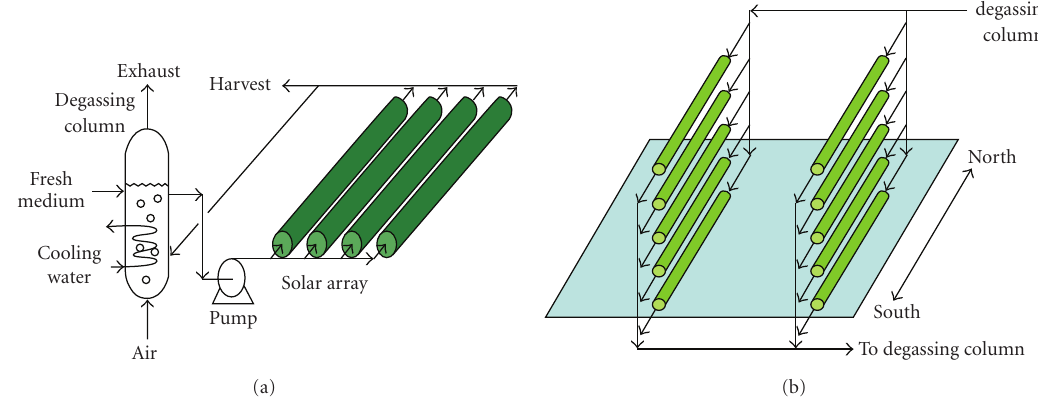
Figure 3: Di ff erent configurations of tubular photobioreactors, extracted from [3]. (a) parallel run horizontal tubes. (b) fence-like tubular